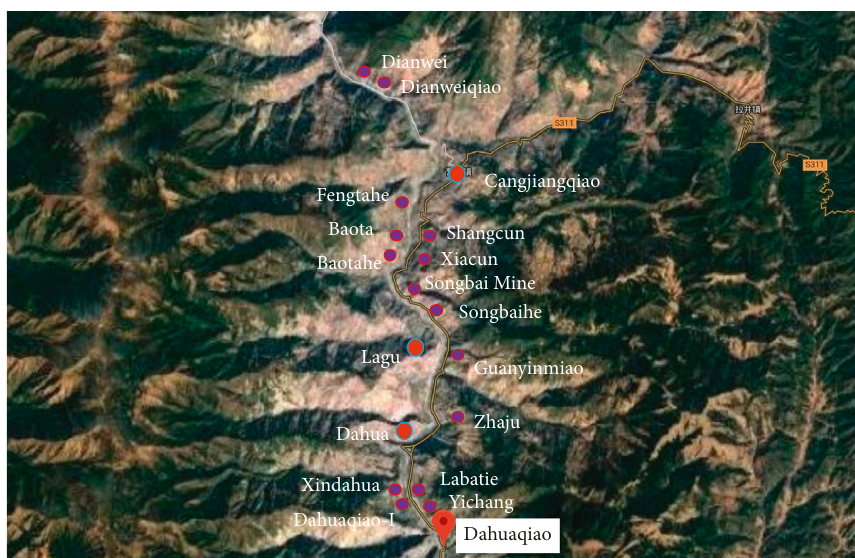
Figure 1: Landslide topography of Dahuaqiao Hydropower Station reservoir area. Table 1: Main characteristics of the 17 landslide-prone areas in Dahuaqiao reservoir